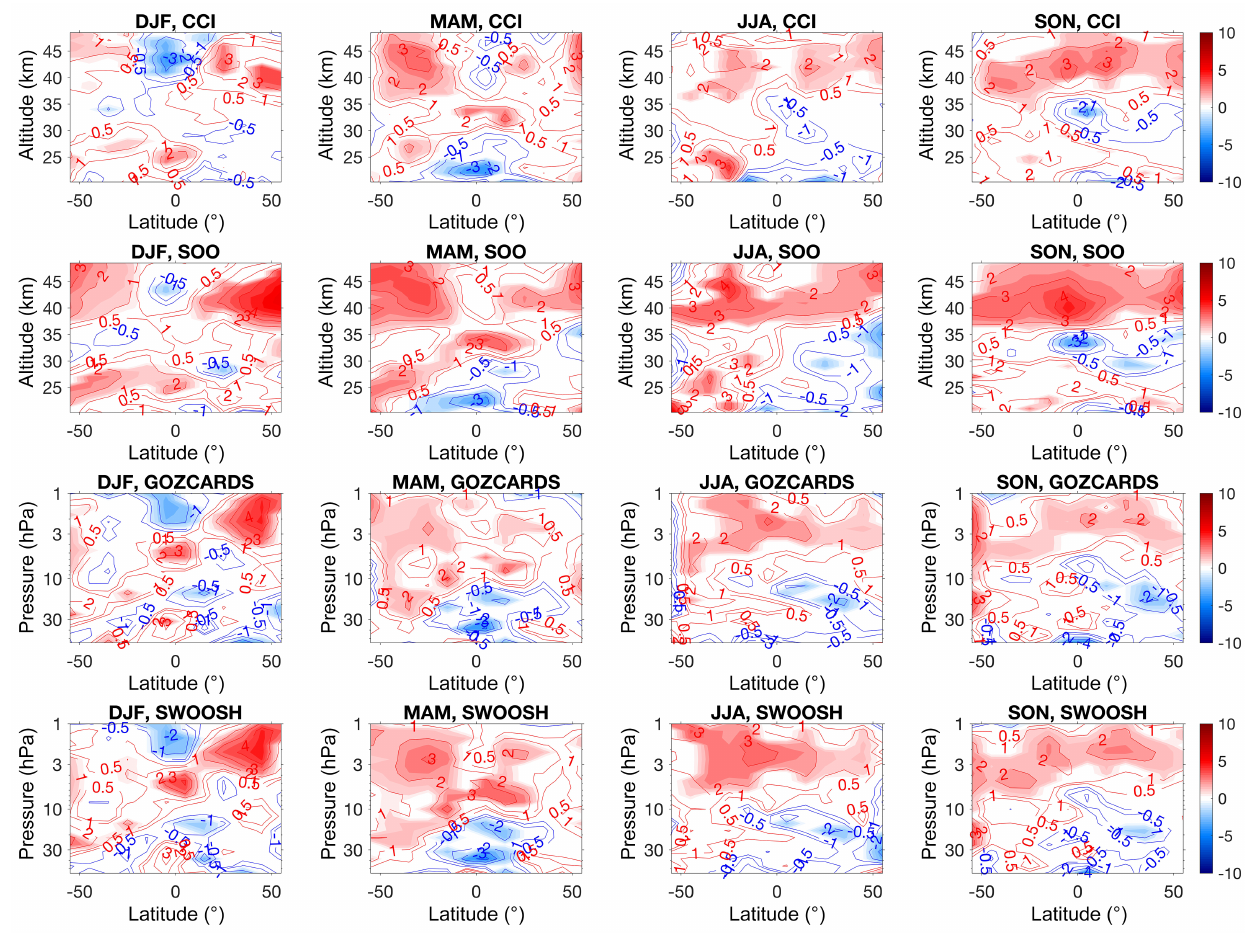
Figure 6. Altitude–latitude variation of linear trends in ozone calculated over 2000–2018 for each season. Data are presented on their natural vertical coordinate: altitude grid for CCI and SOO and pressure grid for GOZCARDS and SWOOSH. The shading denotes trends that are significant at the 95%